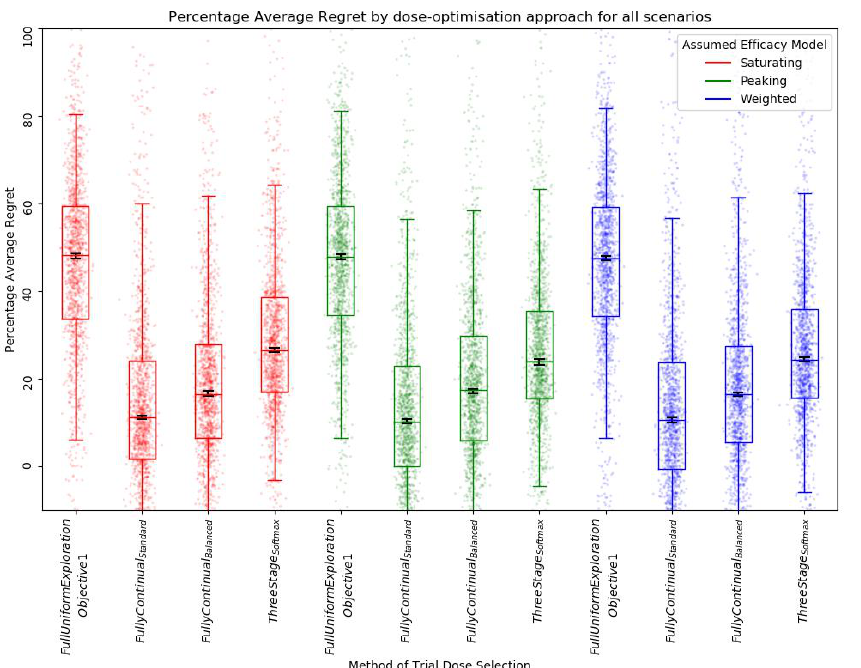
proaches. These findings were the same regardless of the assumed efficacy model.